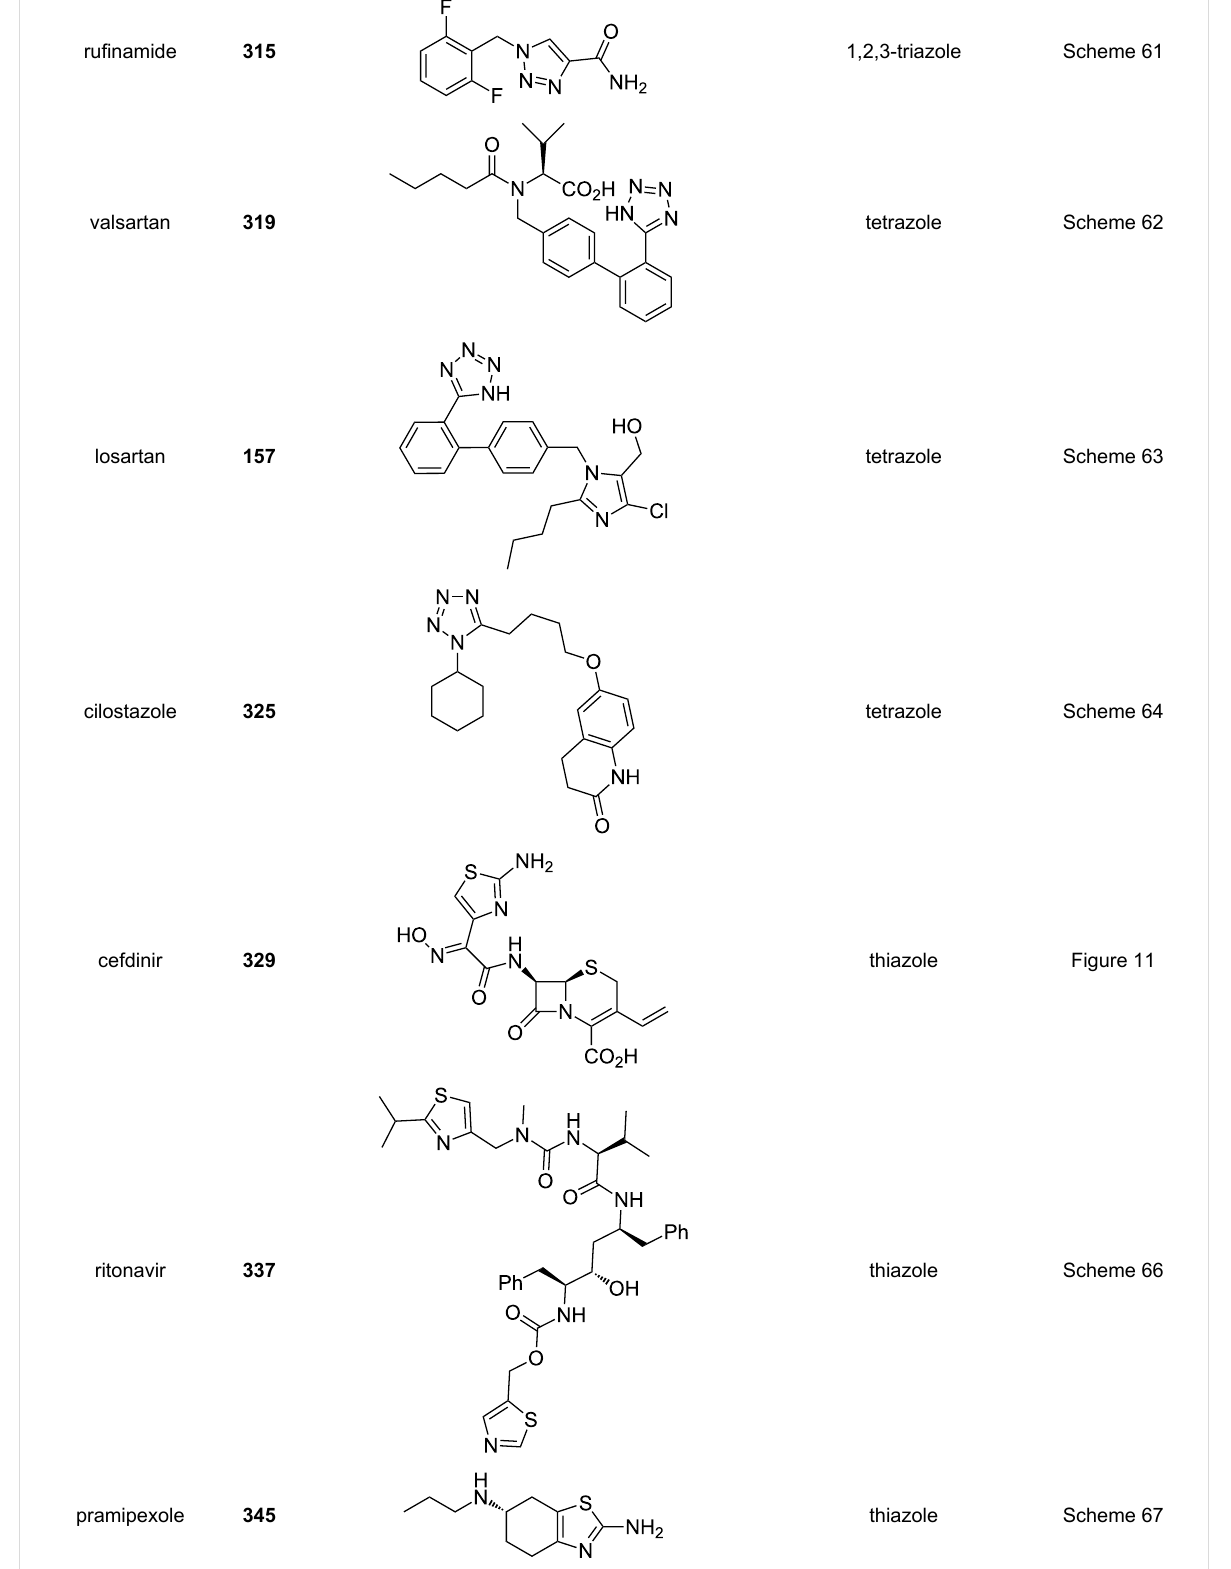
Table 1: Heterocylic structures discussed in this review. (continued)